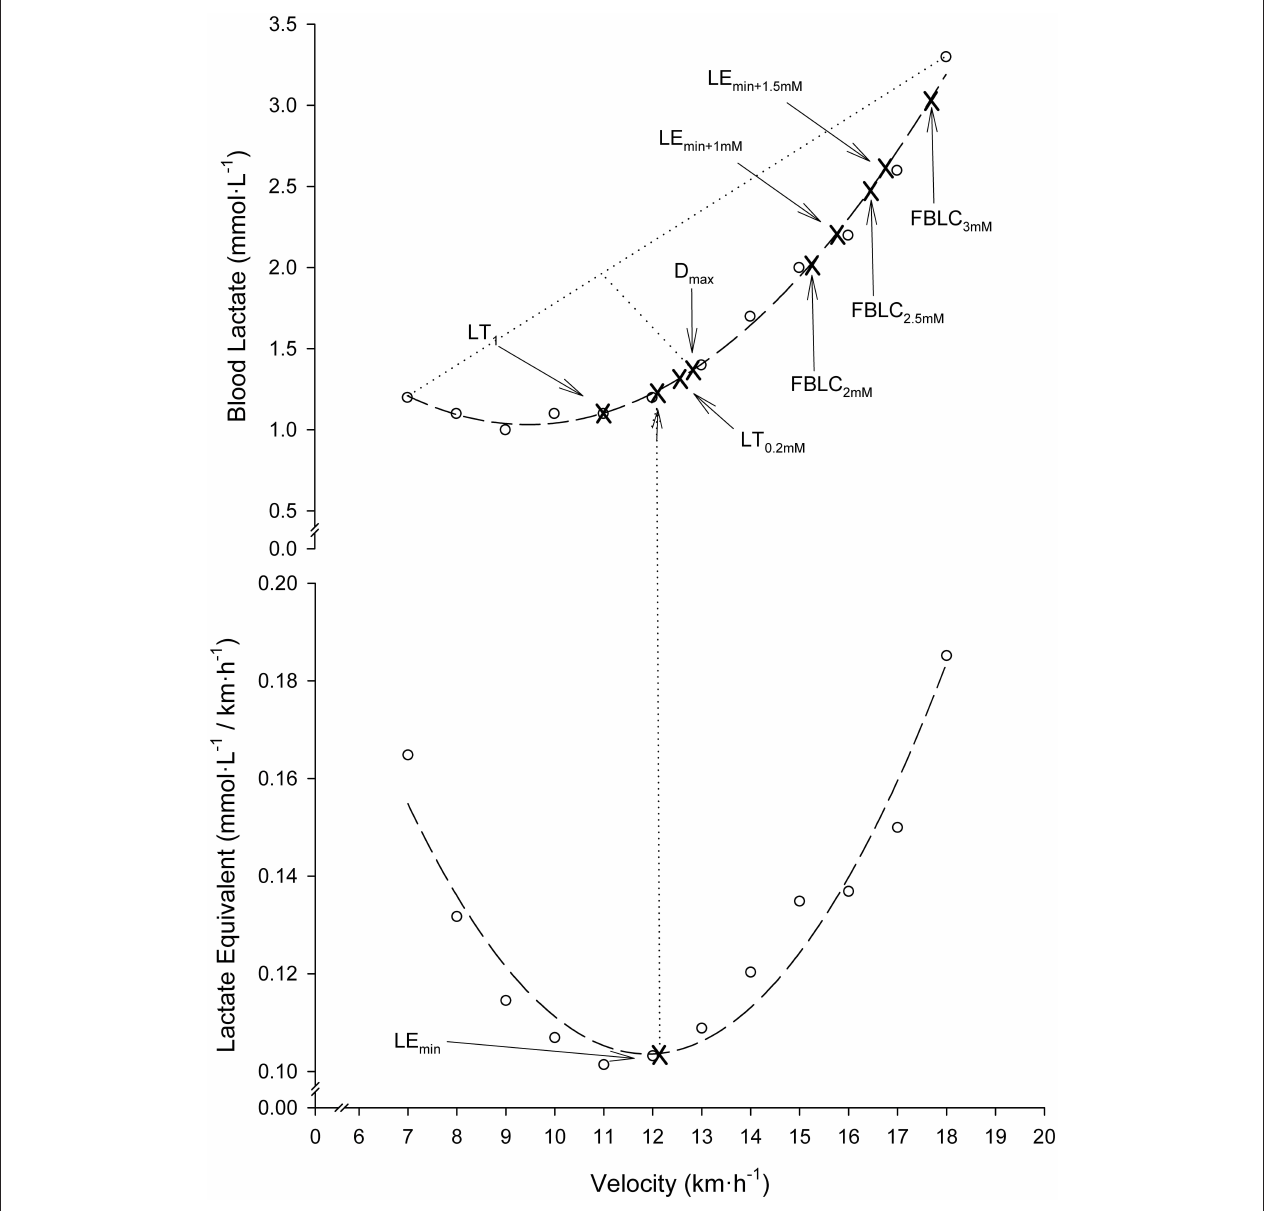
FIGURE 1 | Illustration of blood lactate-related thresholds (BL R Ts) determination in a representative participant. Dashed lines: second-order polynomial curve fits. Dotted lines: the greatest perpendicular distance from the third-order polynomial BLC-velocity curve fit to the generated straight line by the two end data-points of this curve. Note that for clearness of figure presentation, D max determination is illustrated together with the rest of BL R Ts on a second-order polynomial curve fit, although actually it was determined on third-order curvilinear fits as originally described (Cheng et al., 1992).